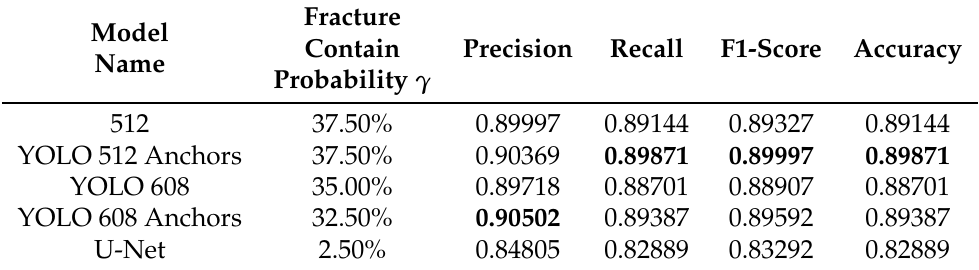
Table 4. Fracture-based evaluation of the models on test set